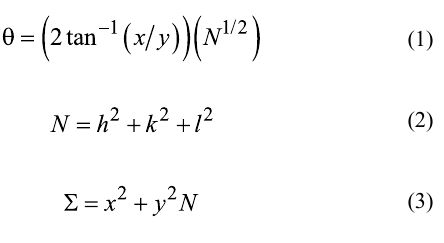
closest-packed (111) plane in face-centered cubic copper is identical to the hexagonal close packed plane in the 2-D crystal structure of the butterfly nipple structure arrangement.The work by Kronberg and Wilson was the foundation for numerous studies over the past six decades, which looked at the signifi- cance of so-called coincidence site lattices (CSLs) for grain- boundary structure and property analyses in engineering ma-